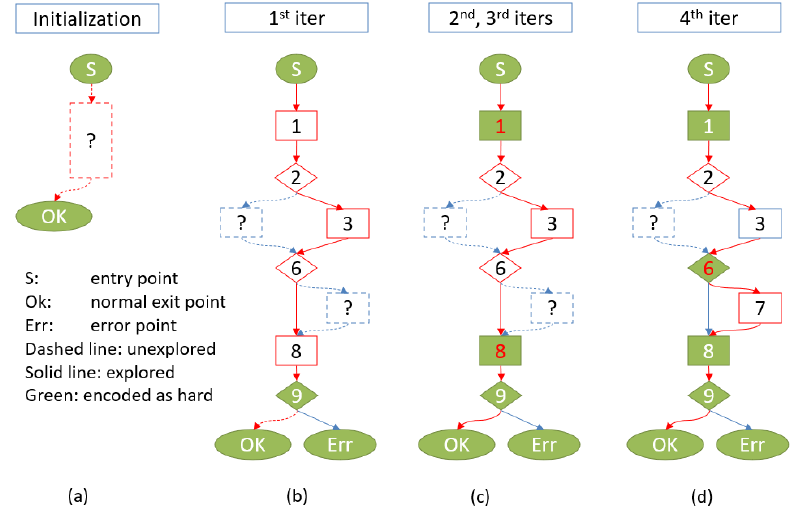
Figure 5. Angelic program encoded during the process of AgxFaults.